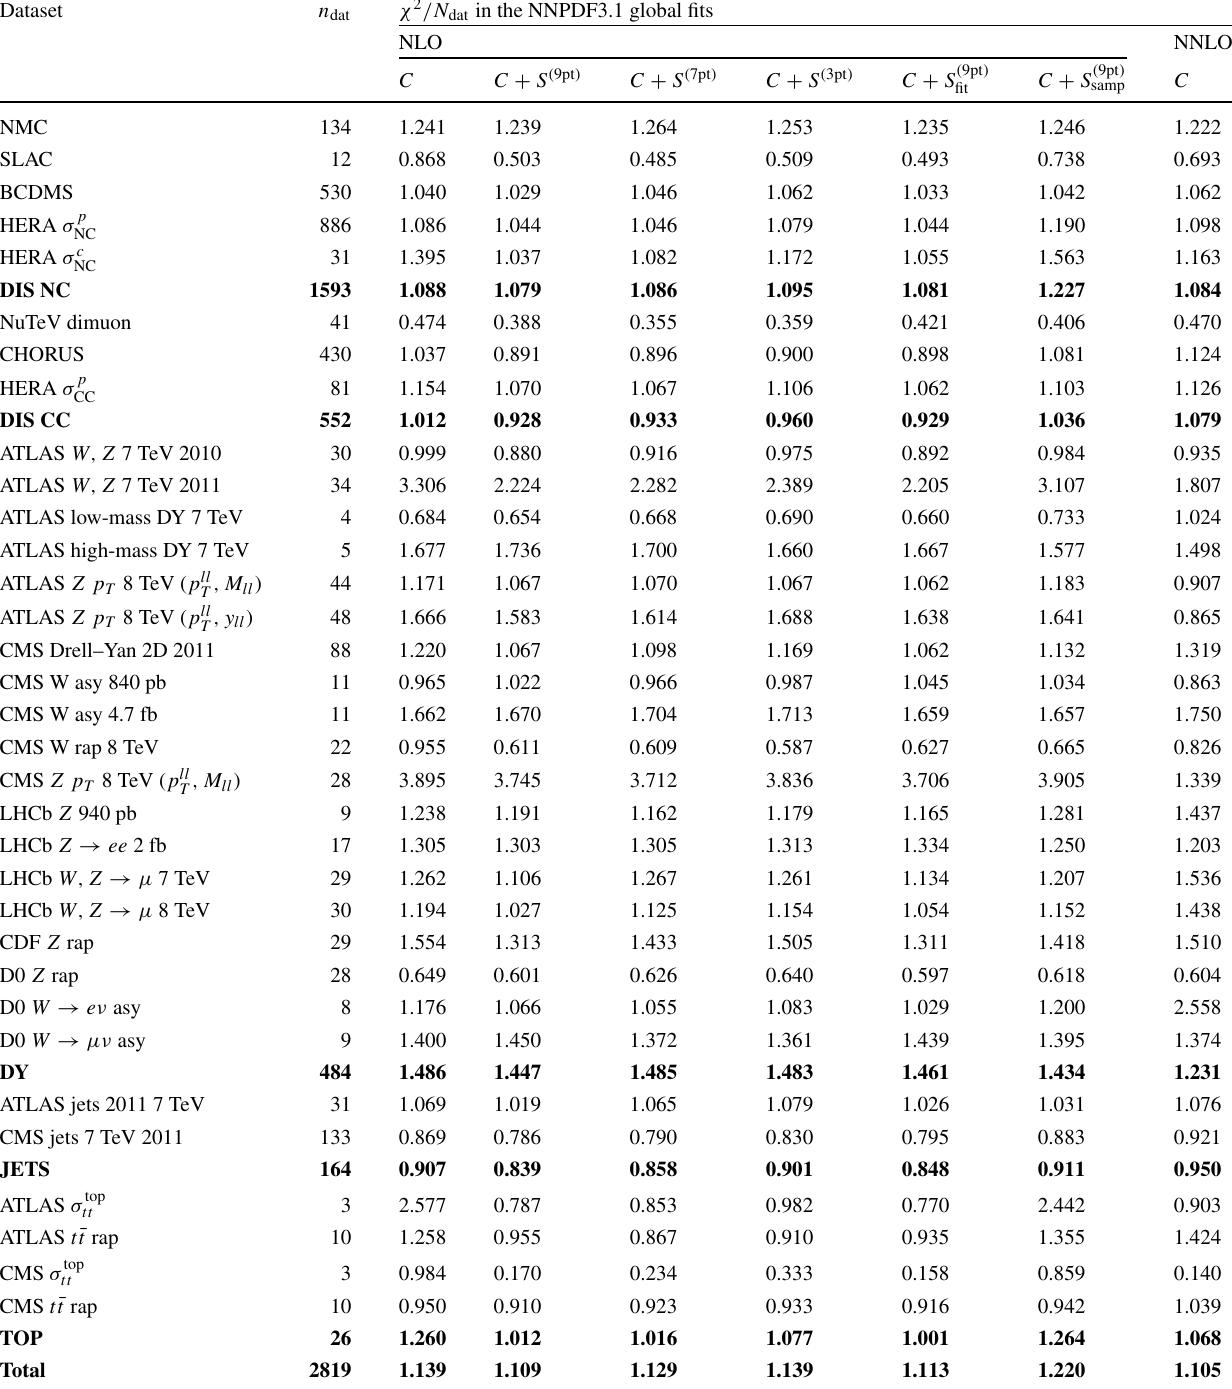
Table 7 The values of the χ 2 / N dat in NLO global fits with the theory covariance matrix S , compared to the results based on including only the experimental covariance matrix C . Results are shown for the 9-, 7-, and 3-point prescriptions. For the 9-point prescription we also show results obtained including the theory covariance matrix in the χ 2 defi-